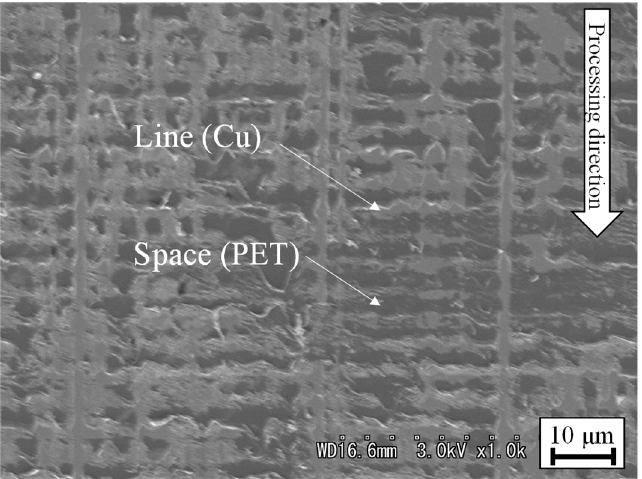
Figure 7. SEM image of the SS-processed Cu/PET film at a W = 3.0 N contact force. Processing conditions: T = 5.80 N, θ = 150.0°, V = 10.0 mm/min, and L = 1.0 mm.